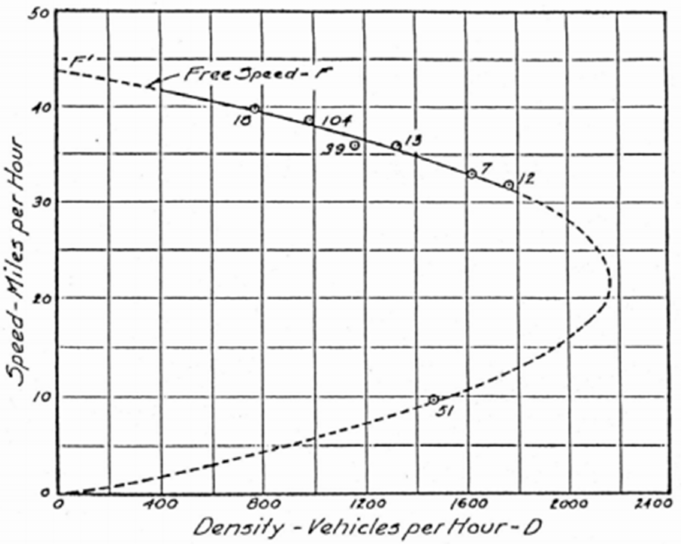
Figure 2. Greenshield’s fundamental diagram of traffic flow, source: